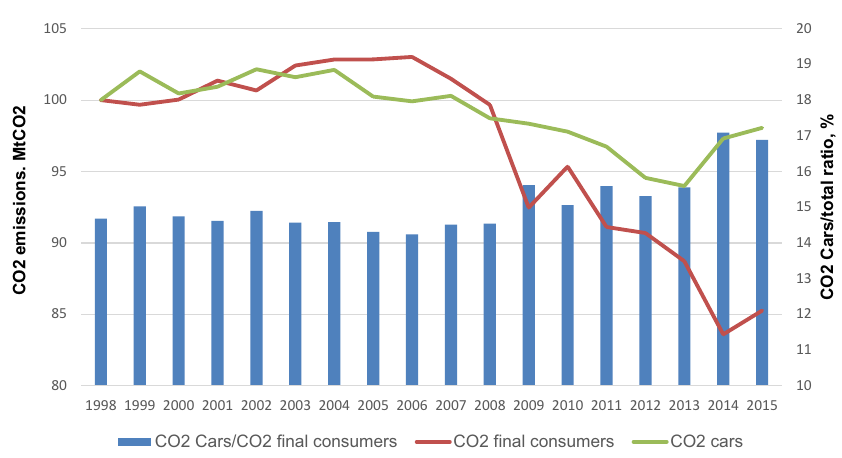
Fig. 5 CO 2 emissions in main Western EU countries from cars and final consumers (Index: year 1998 =